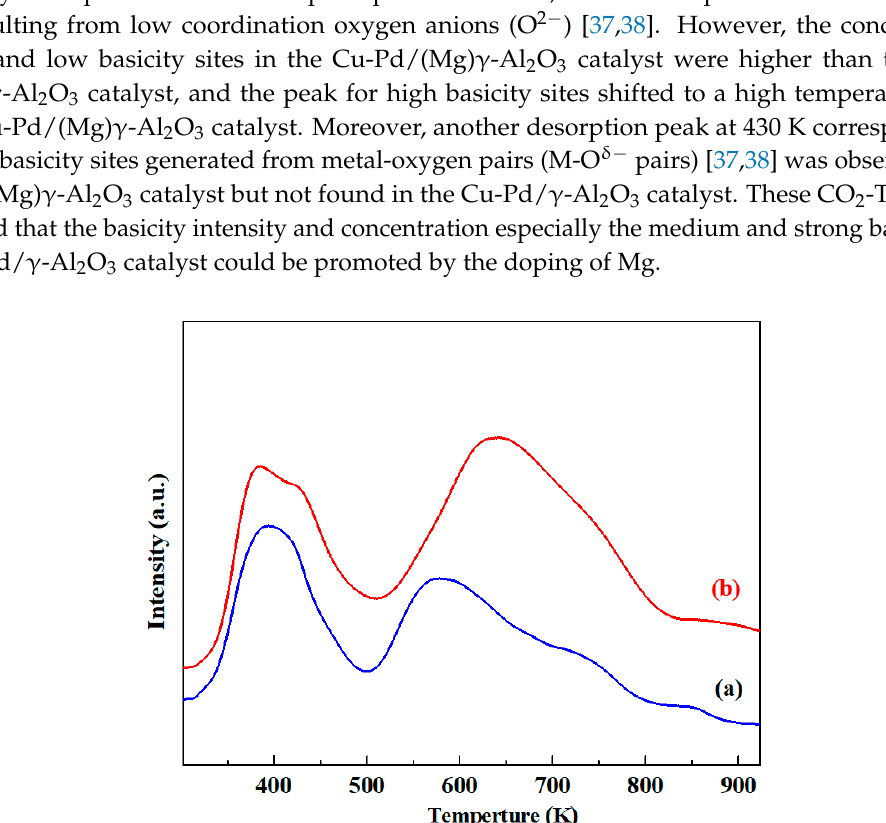
Figure 5. FTIR spectra of pyridine adsorbed of the samples: ( a ) Cu-Pd/ γ -Al 2 O 3 measured after heating at ( 1 ) 303 K, ( 2 ) 373 K, ( 3 )473 K; ( b ) Cu-Pd/(Mg) γ -Al 2 O 3 measured after heating at ( 1 ) 303 K, ( 2 ) 373 K, ( 3 ) 473 K.